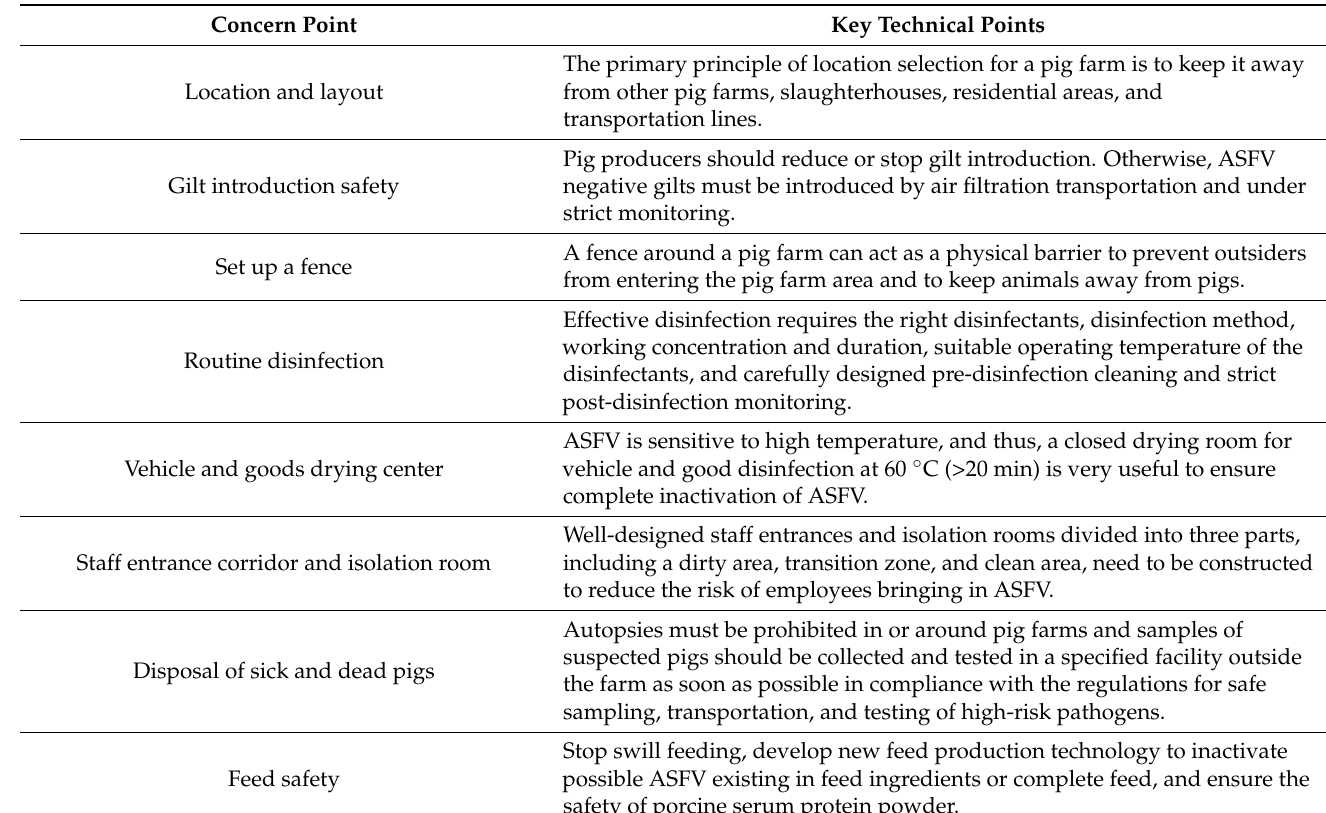
Table 4. Eight concerns of a typical pig farm biosecurity